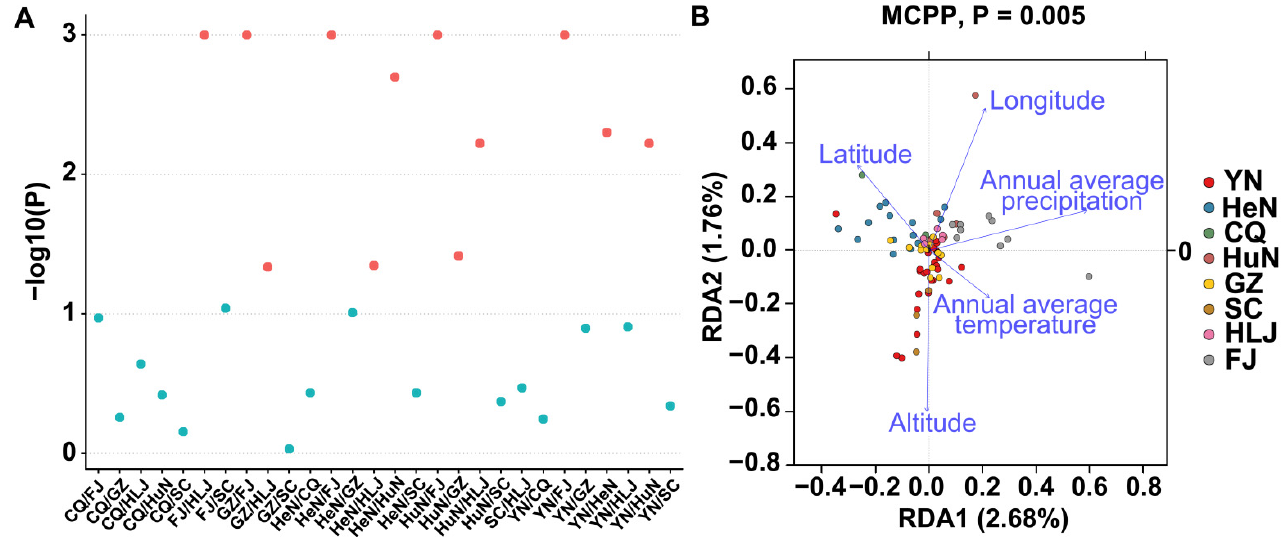
Figure 4. β -diversity and redundancy analysis. ( A ) Multi Response Permutation Procedure (MRPP). The composition difference between each province was valued by − log10 ( p ). The red dots are the pairs that differ significantly, while the blue dots are those that do not differ. More than half of the pairs showed significant differences, indicating that the microbial community composition varies greatly from province to province. ( B ) Redundancy analysis. The relationship between the microbial diversity and temperature, precipitation, altitude, longitude, and latitude of each sample was analyzed. Each arrow represents an environmental factor, with each dot representing one sample. An acute angle between arrows indicates a positive correlation, an obtuse angle indicates a negative correlation, and a right angle indicates no